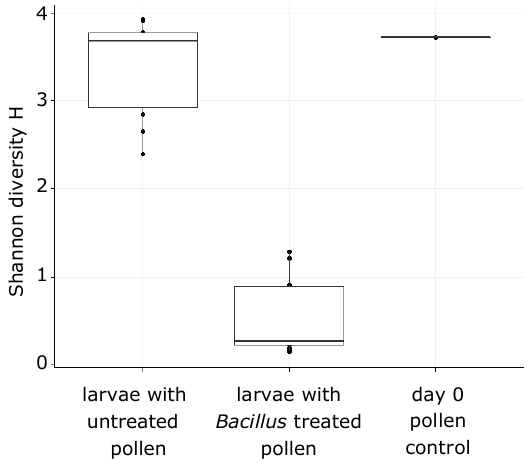
Figure 4. Shannon diversity of bacterial taxa found in (left) 11 larvae which fed on untreated pollens, (middle) 10 larvae which fed on sterilized pollen which was inoculated with the Bacillus sp. strain, and (right) one pollen sample at day zero of the experiments and then used to feed the